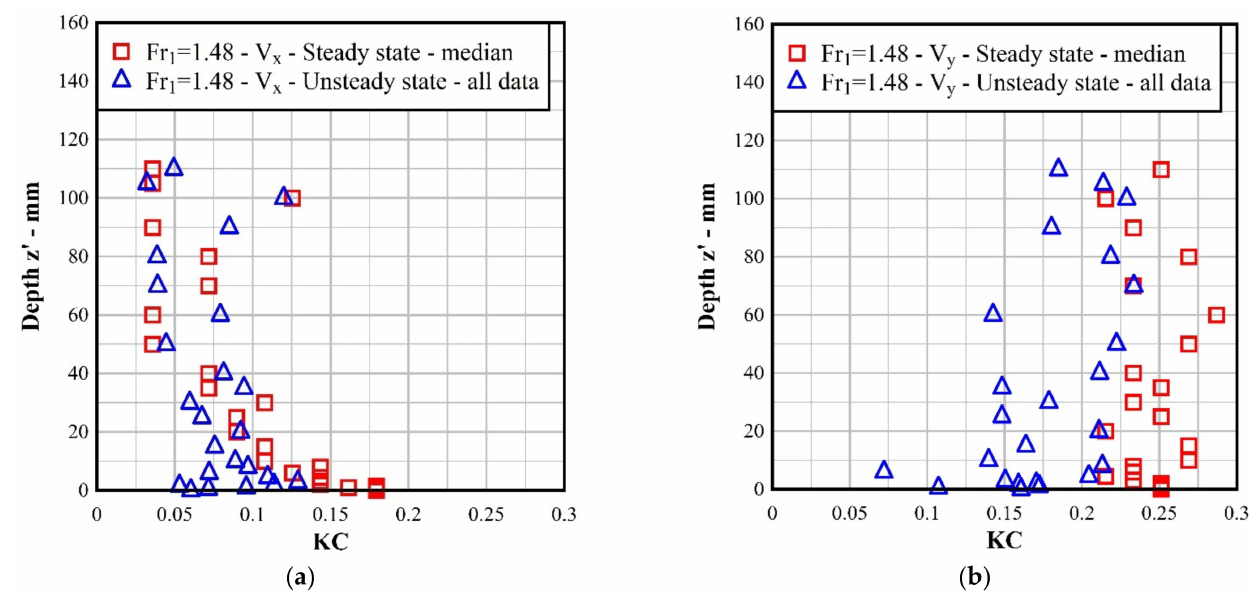
Figure 9. Breaking surge, Run 60-6. Kolmogorov complexity vs. vertical elevation z (cid:48) for ( a ) V x ; ( b ) V y